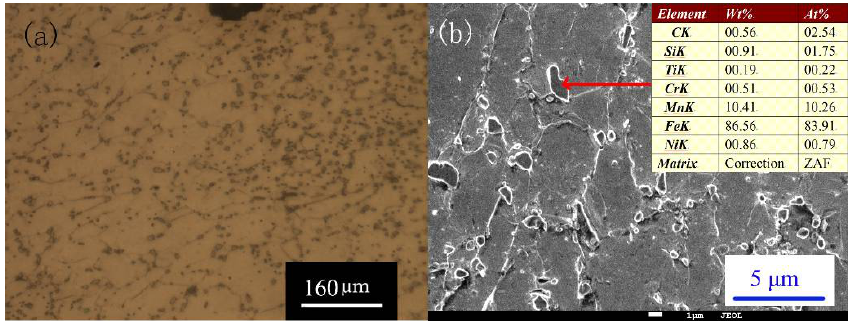
Figure 1. Optical micrograph ( a ), secondary electron micrograph ( b ), and the energy-dispersive X-ray spectroscopy results ( inset ) of the as-received steel.